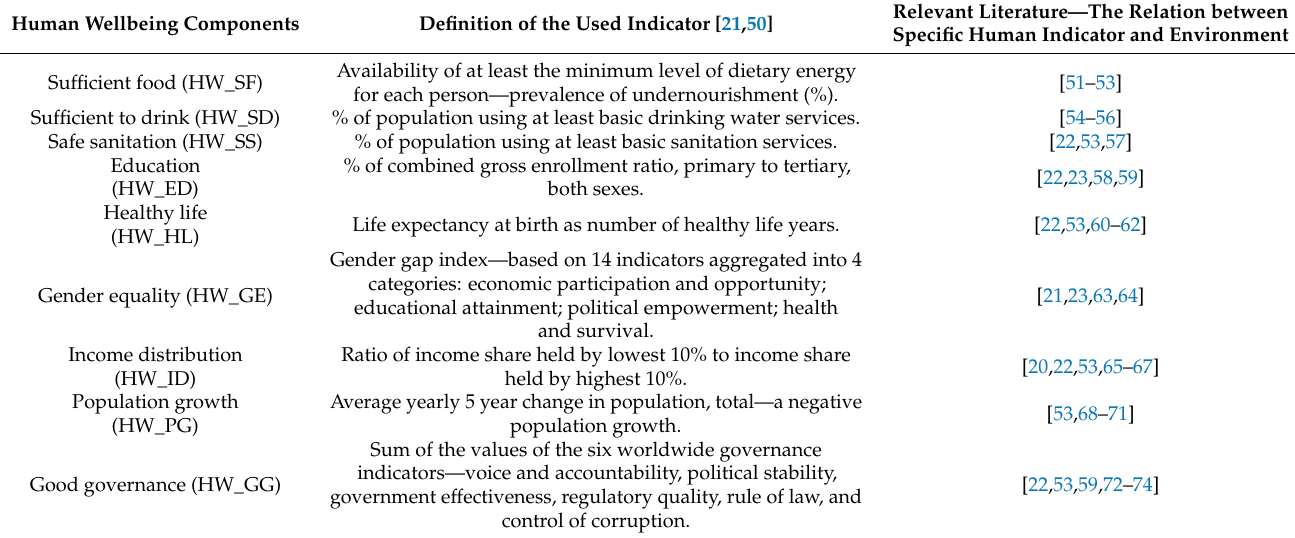
Table 2. Definition of human wellbeing’s